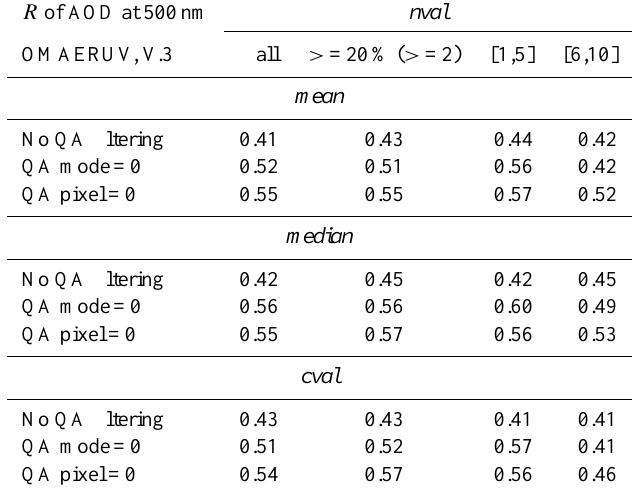
Table 4. Correlation coefficient ( R ) between means , medians , and cvals (value of the central pixel in the sample) of AERONET AOD and OMI AOD at 500nm depending on different OMI data screening scenarios. Factors considered for the screening include QA (Quality Assurance) flags of individual data pixels, mode of QA flags of all valid pixels in the sample, and nval (number of valid pixels in the sample). OMI QA value of 0 indicates the data with the best quality. AERONET data was interpolated to 500nm and screened to have nval of at least 4. OMI data was additionally screened to exclude data points with AOD > =6, which comprise 130 of approximately 50000 data points when computing the statistics for “No QA filtering”, and 5 of approximately 35000 data points when computing the statistics for “QA mode=0”. R of AOD at 500nm